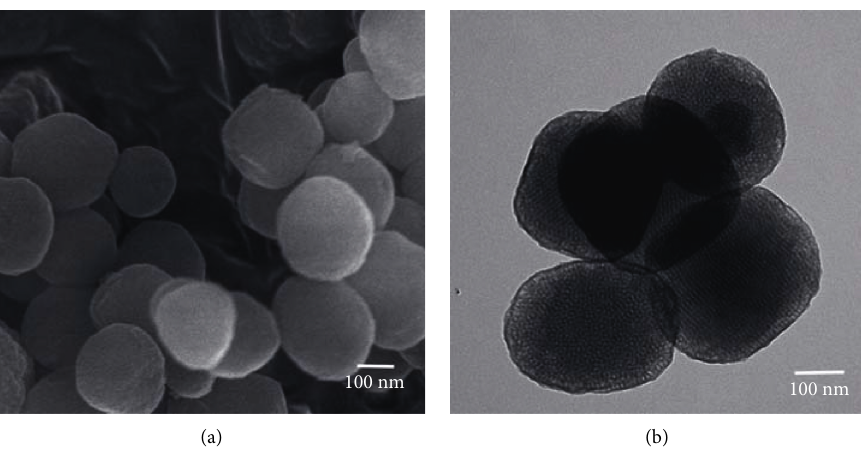
Figure 2: Images of mesoporous silica nanoparticles: (a) SEM and (b) TEM.